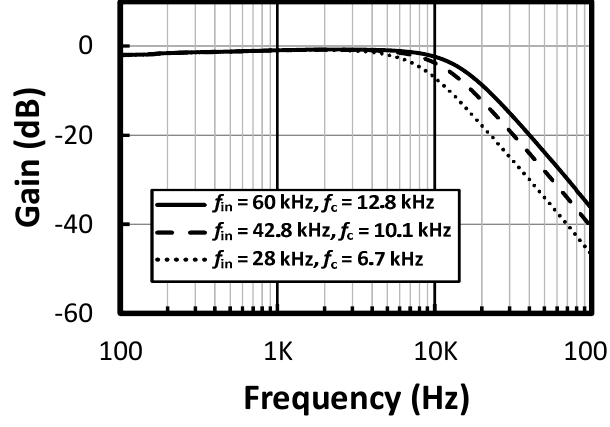
Figure 18. The measured frequency responses of LPF for an ATL input clock of 28, 42.8 and 60 kHz.